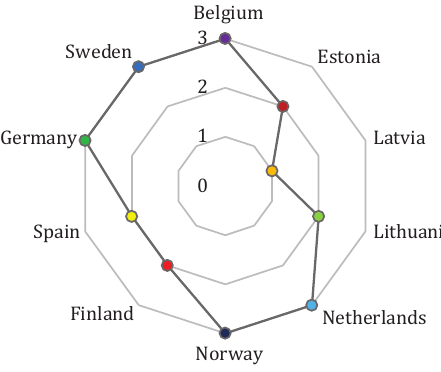
Figure 10. Comparison of pedestrian crossing sign RA class minimum requirement among countries